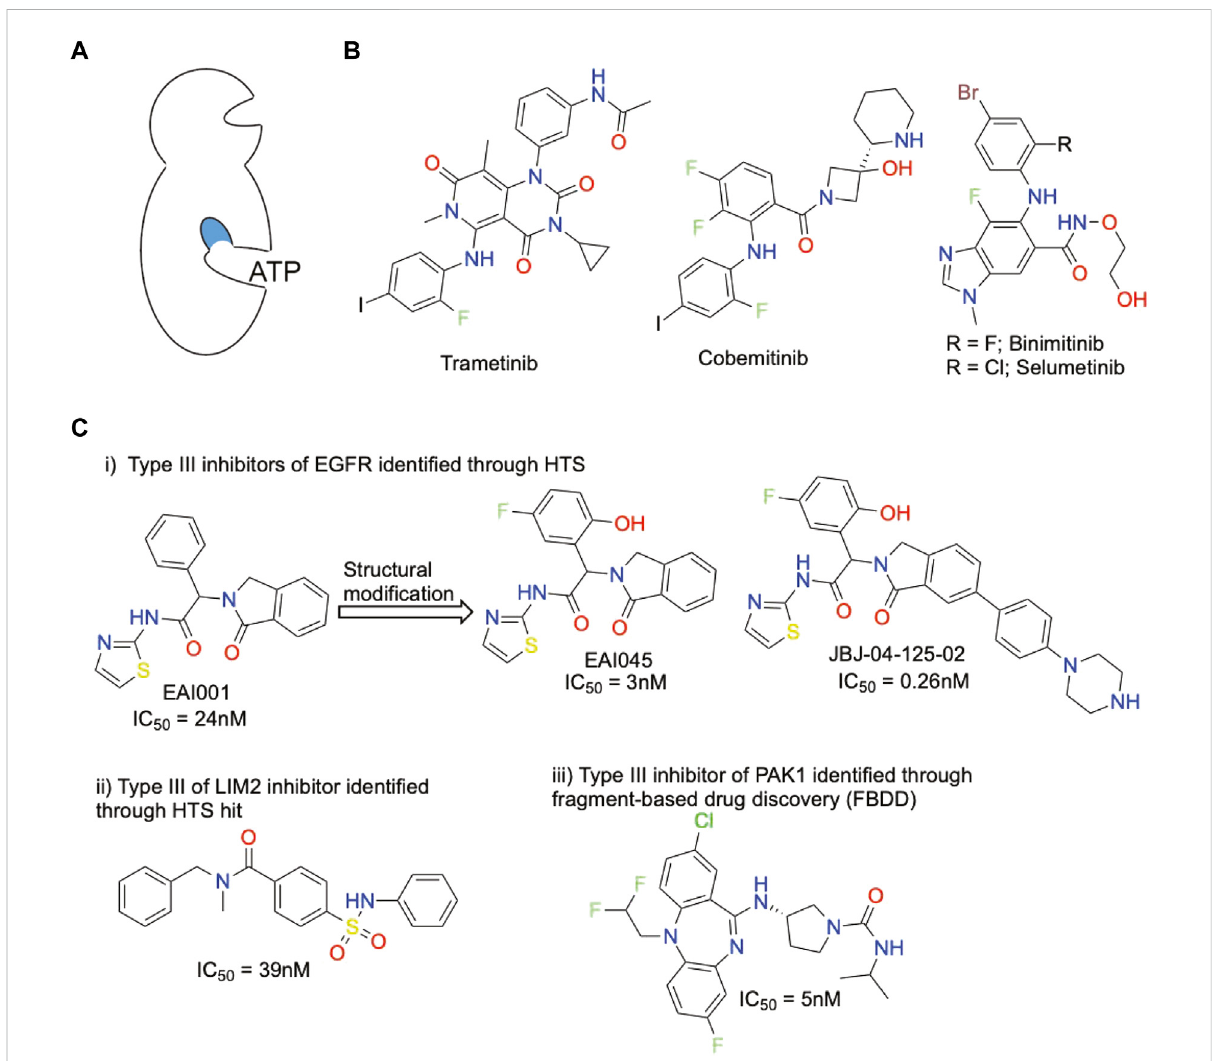
FIGURE 3 Representative chemical structures displaying a kinase inhibitory activity of Type III and their potency toward speci fi c kinases. (A) Schematic representation of Type III allosteric site. Blue color indicates targetted site. (B) FDA-approved Type III HEK inhibitors (C) Type III kinase